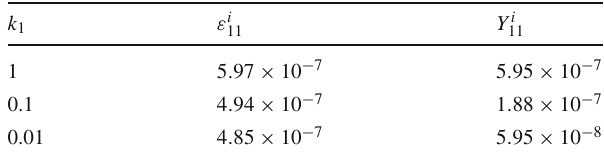
Table 1 The values of the CP violation parameter, ε i coupling, Y i ,associatedwith N R , 1 interactionarelistedforthreevalues 11 / H of k 1 = (cid:12) i 11